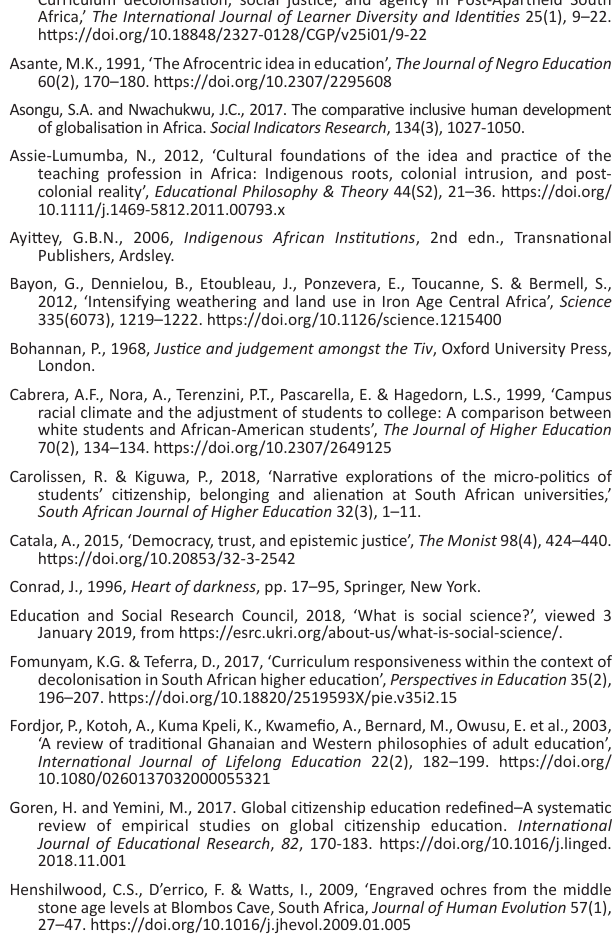
FIGURE 1: Interplay of African, global and western epistemologies in the curriculum.